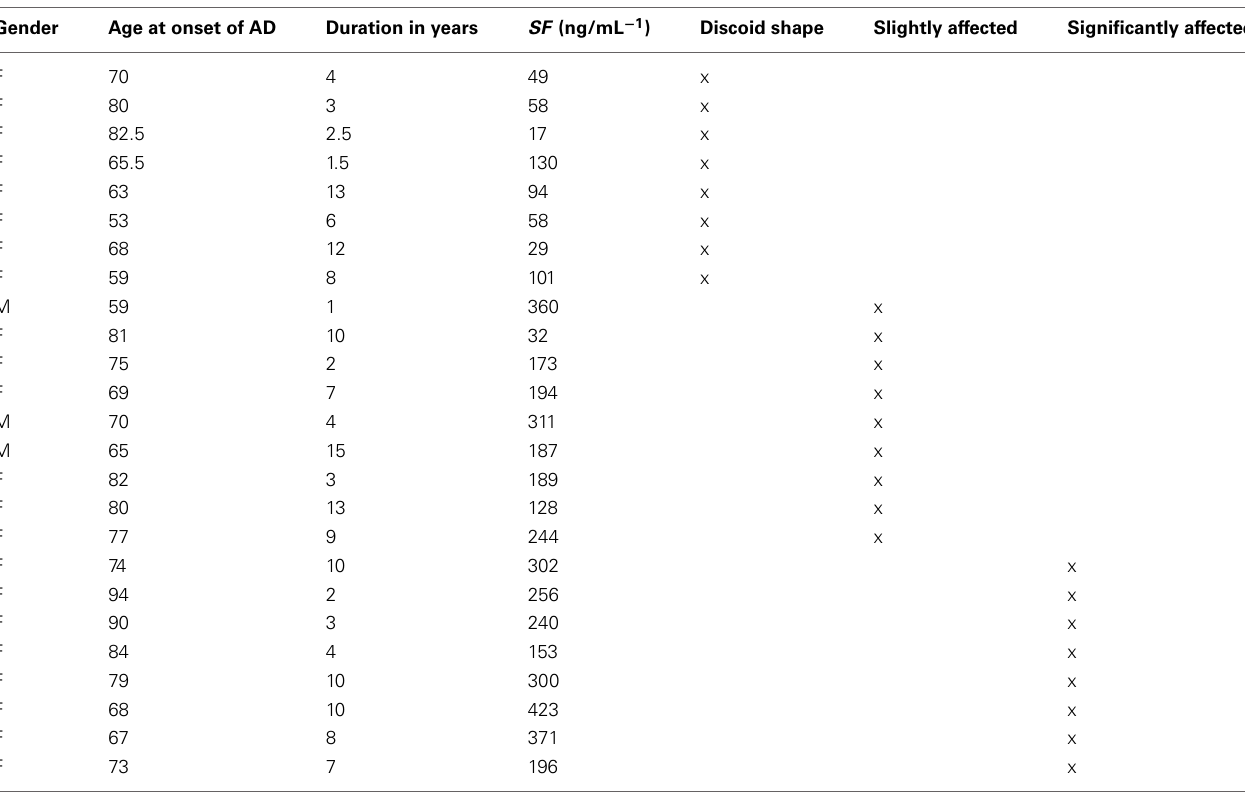
Table 4 | Alzheimer’s disease patient data, showing duration and age of onset and serum ferritin (SF) levels, as well as severity of changes, indicated as normal discoid morphology, slightly affected and severely affected shape